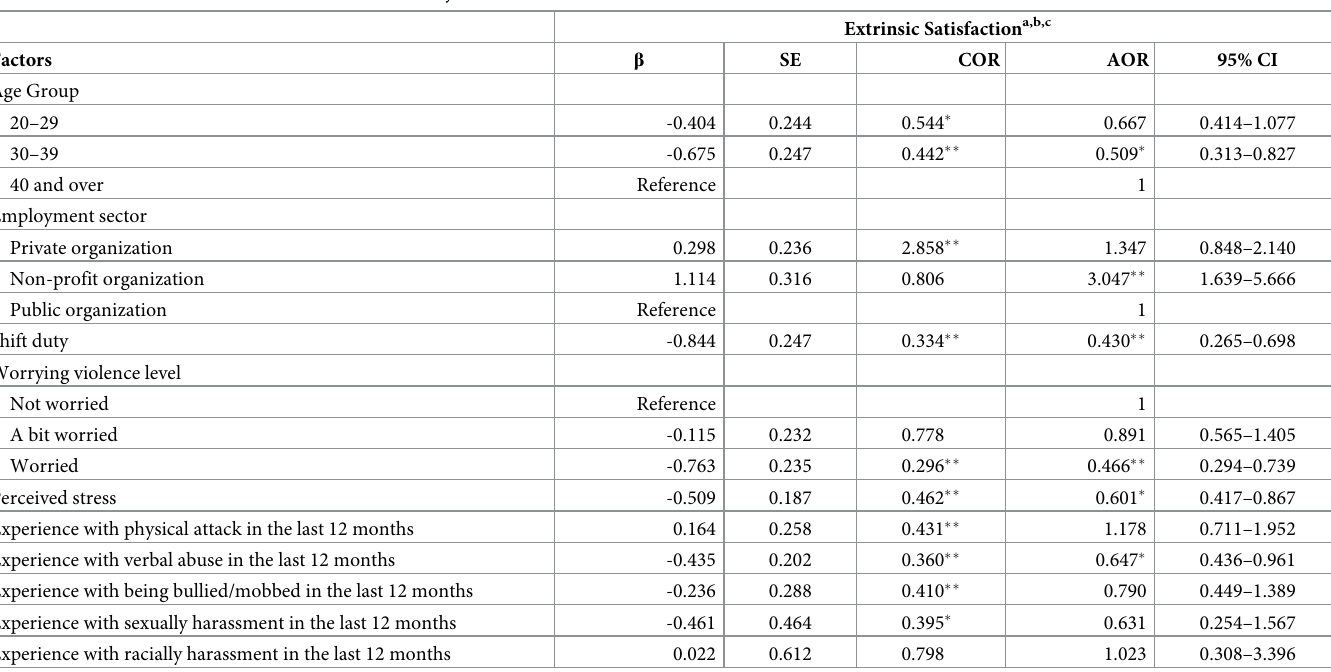
Table 8. Association between risk factors and extrinsic job